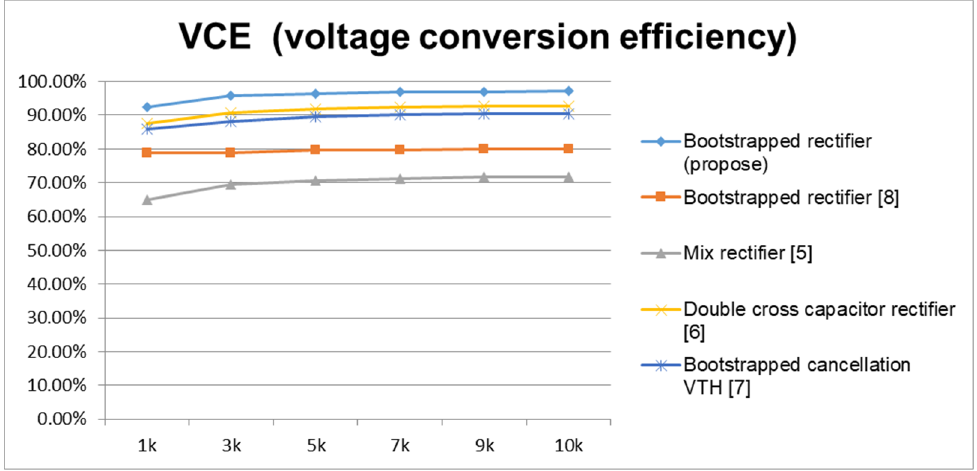
Figure 19. Adjusting the VCE RL for various rectifiers.